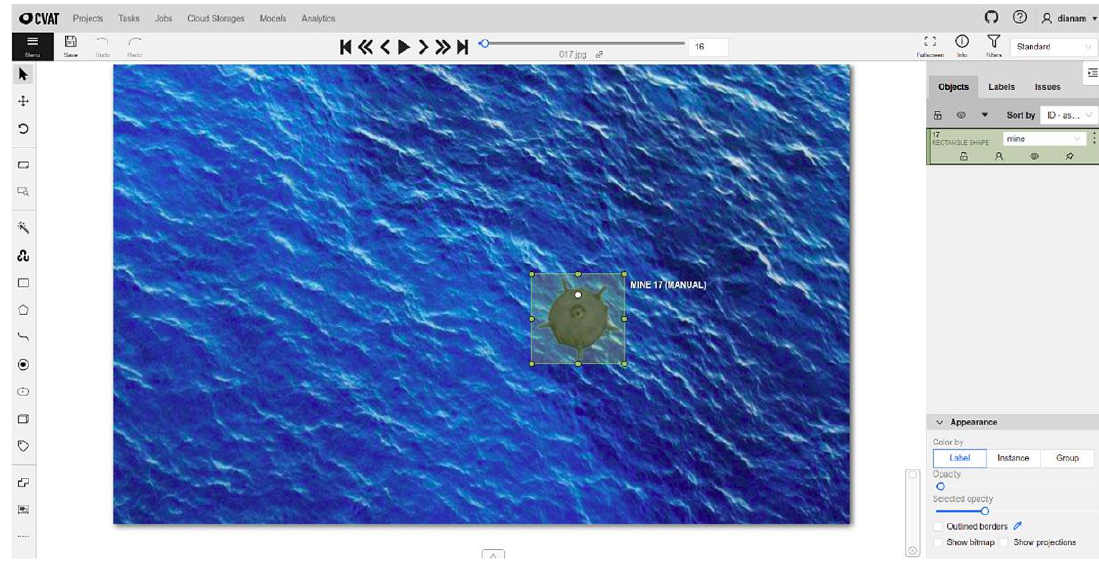
Figure 9. Annotating floating hand CVAT images.